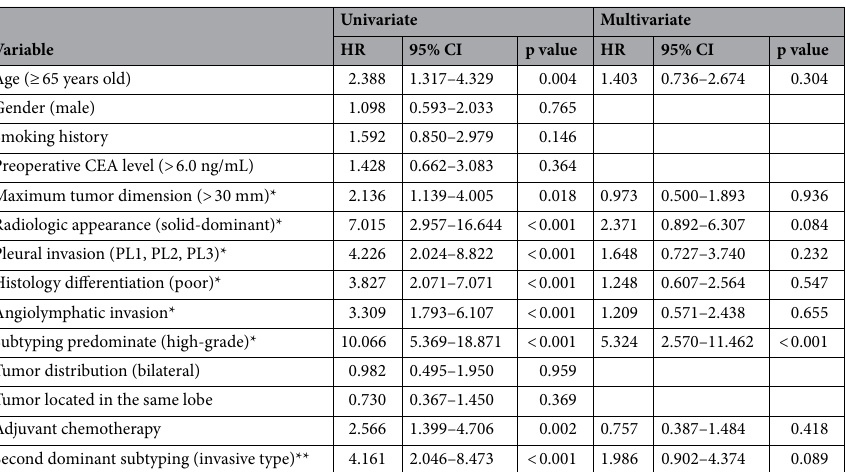
Table 3. Cox proportional hazard model for disease-free survival in 149 patients. Calculated by Cox regression method. CEA Carcinoembryonic antigen. *Dominant tumor. **Second dominant tumor with other than lepidic predominant